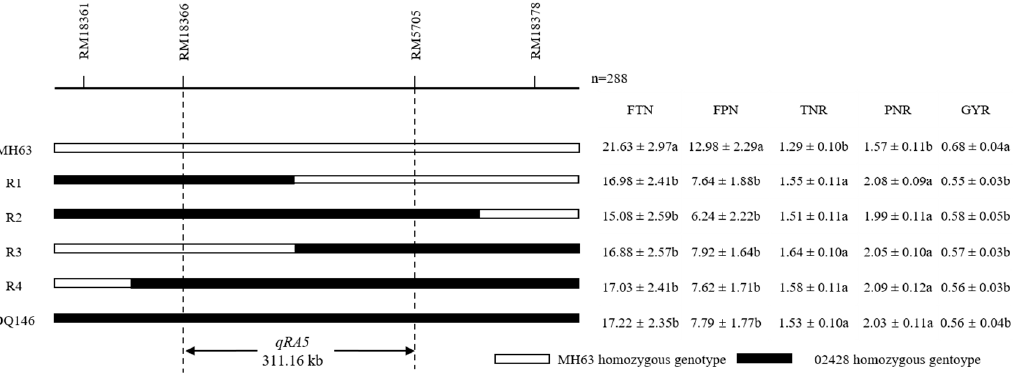
Figure 3. Substitution mapping of qRA5 . Letter a or b represent significance between them at level of p < 0.05. FTN, maximum tiller number per plant in the first season; FPN, panicle number per plant in the first season; TNR, maximum tiller number ratio of RTN to FTN; PNR, panicle number ratio of RPN to FPN; GYR, grain yield ratio of RGY to